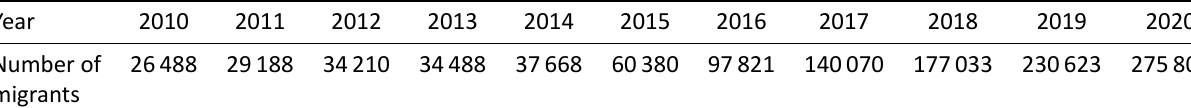
Table 2. Estimation of emigration to Poland for a temporary stay in 2010–2020.